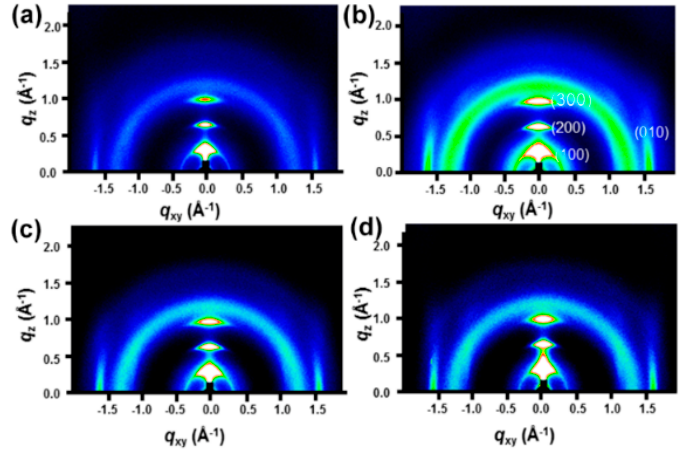
Figure 4. Grazing-incidence wide-angle X-ray scattering diffraction patterns of poly(3-hexylthiophene):[6,6]-phenyl-C 61 -butyric acid methyl ester thin films deposited on ( a ) poly(3,4-ethylenedioxythiophene):poly(styrenesulfonate) (PEDOT:PSS) and PEDOT:PSS combined with ( b ) 5, ( c ) 20, and ( d ) 50 µL of oleylamine-functionalized MoS 2 .